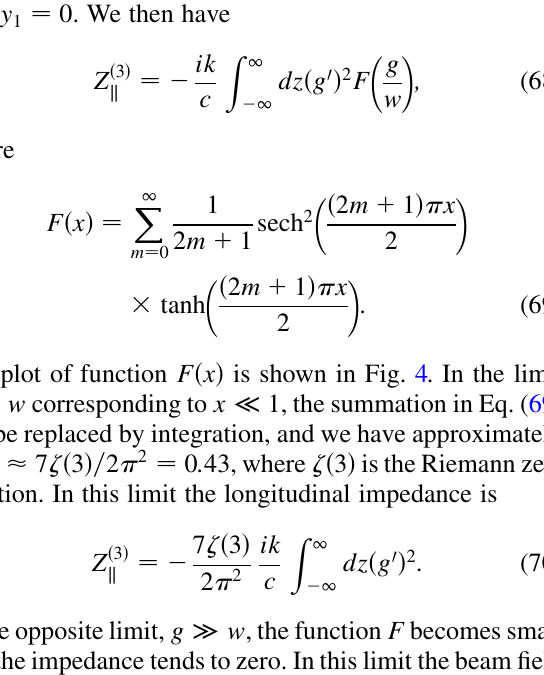
FIG. 4. Plot of function F (cid:3) x (cid:4) .